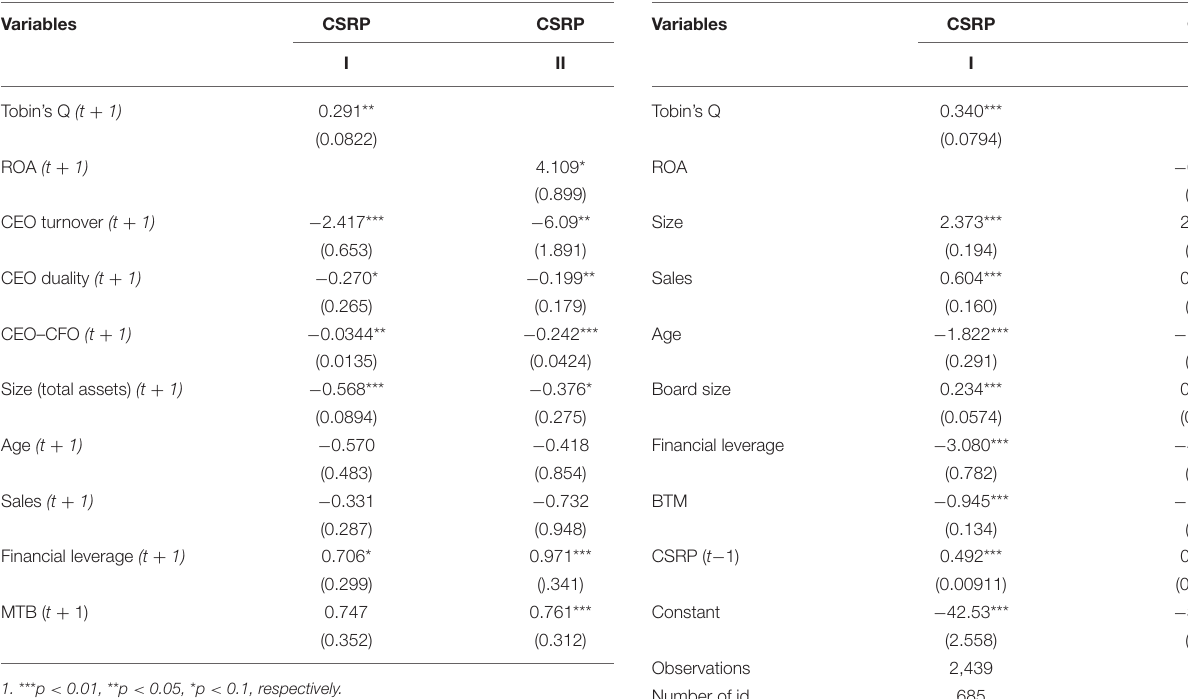
TABLE 3 | Strict exogeneity tests. TABLE 4 | CSRP–CFP relationship (system GMM parameter